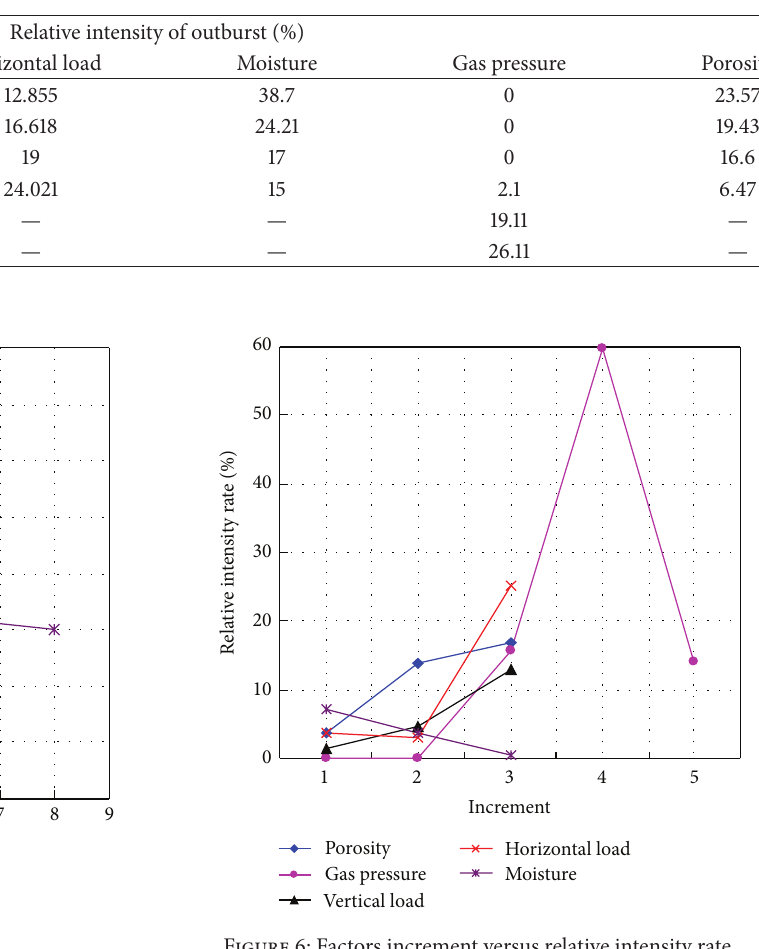
Figure 5: Factors increment versus relative intensity of outburst of coal and gas. Units in 𝑋 -axis normalized are shown in Table 1.